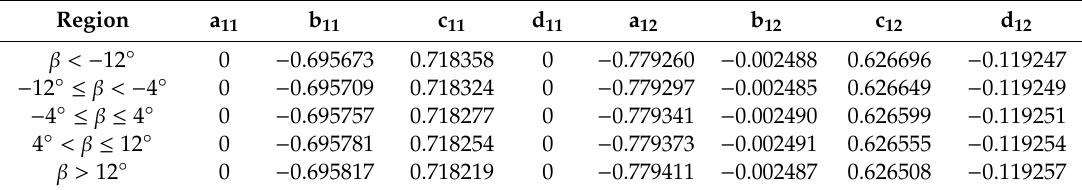
Table 2. The database of intrinsic parameters for the transmitter 1.